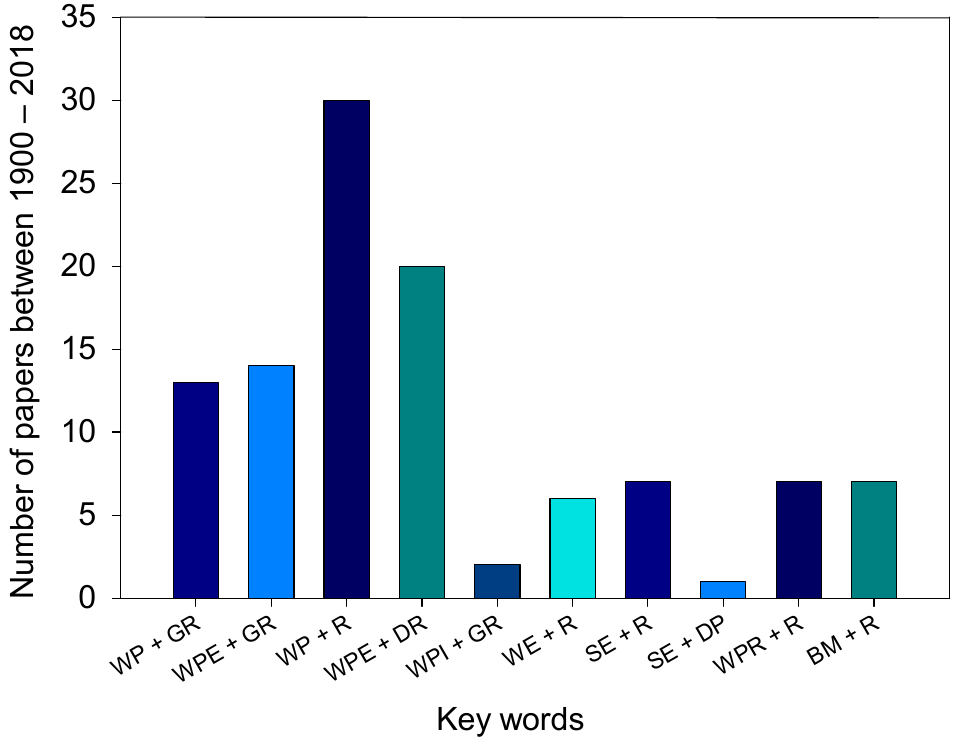
Figure 1. Number of studies related to the woody plant encroachment impacts on groundwater recharge retrieved from the Web of Science database (1900–2018) using different key words combinations. WP = woody plant; WPE = woody plant encroachment; WPI = woody plant invasion; WE = woody expansion; SE = shrub encroachment; WPR = woody plant removal; BM =